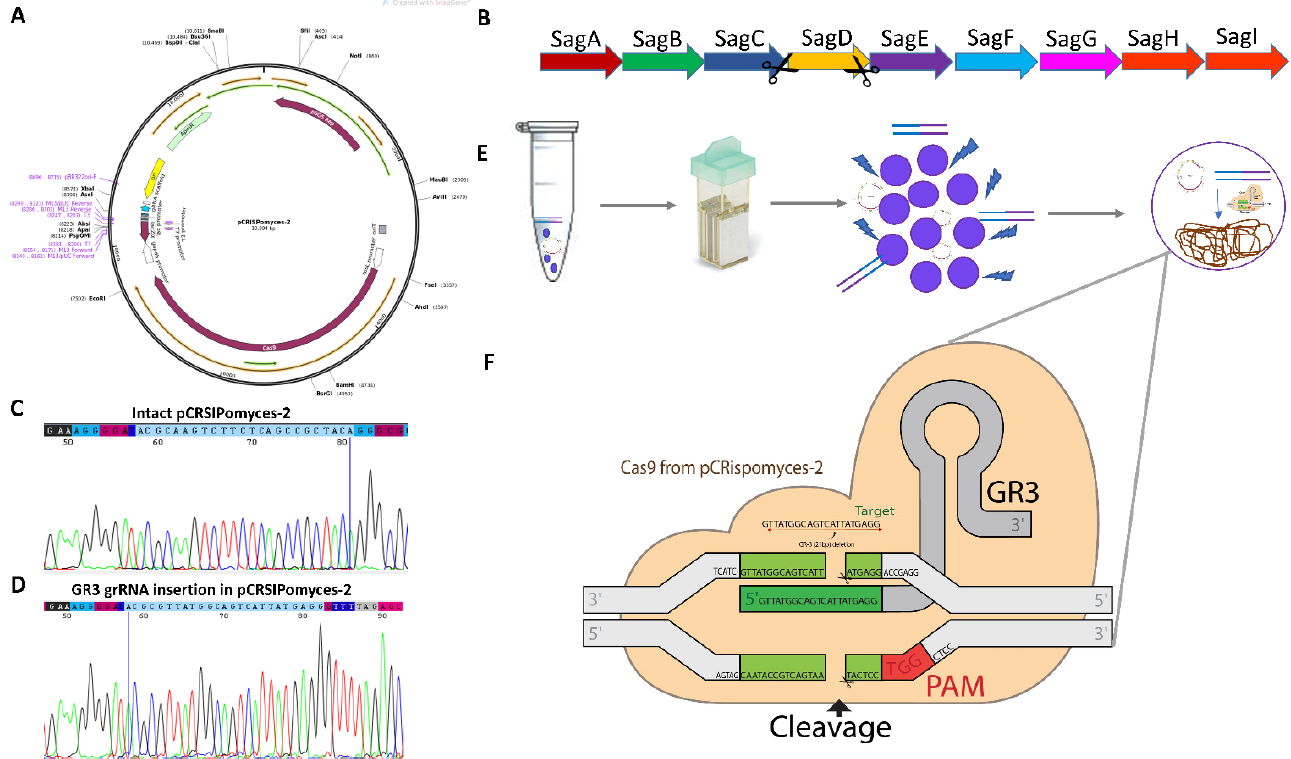
Figure 1. CRISPR-Cas9 system for knockout. ( A ) Intact PCRISPomyces-2 plasmid. ( B ) Streptolysin cassette showing Sag-ABCDEFGHI genes for streptolysin biosynthesis. ( C ) Intact/Un-edited pCRISPomyces-2 plasmid. Incorporation of GR2 gRNA sequence into the PCRISPomyces-2 plasmid. ( D ) Incorporation of GR3 gRNA sequence into the PCRISPomyces-2 plasmid. ( E ) Workflow showing an experimental design for inserting the pCRISPomyces-GR3 using electroporation. ( F ) Schematic diagram showing the mechanism for gene editing using GR3.